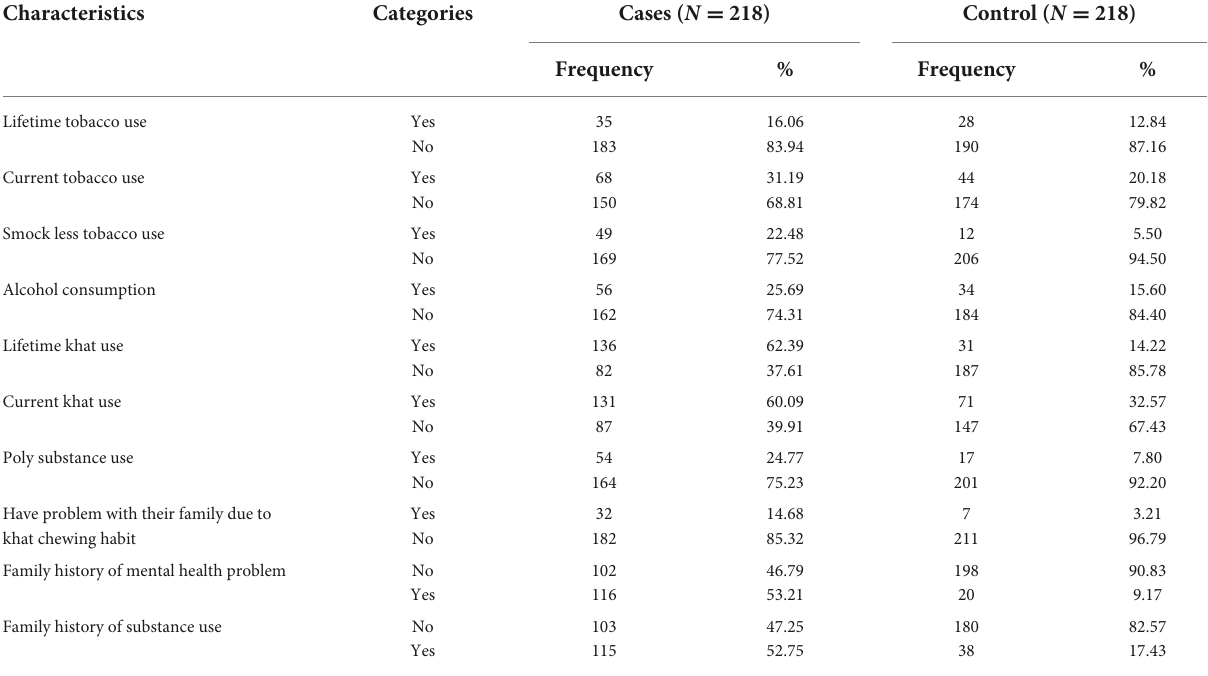
TABLE 2 Substance use characteristics of study participants at selected public Hospitals in eastern Ethiopia from December 1, 2021 to January 30, 2022.